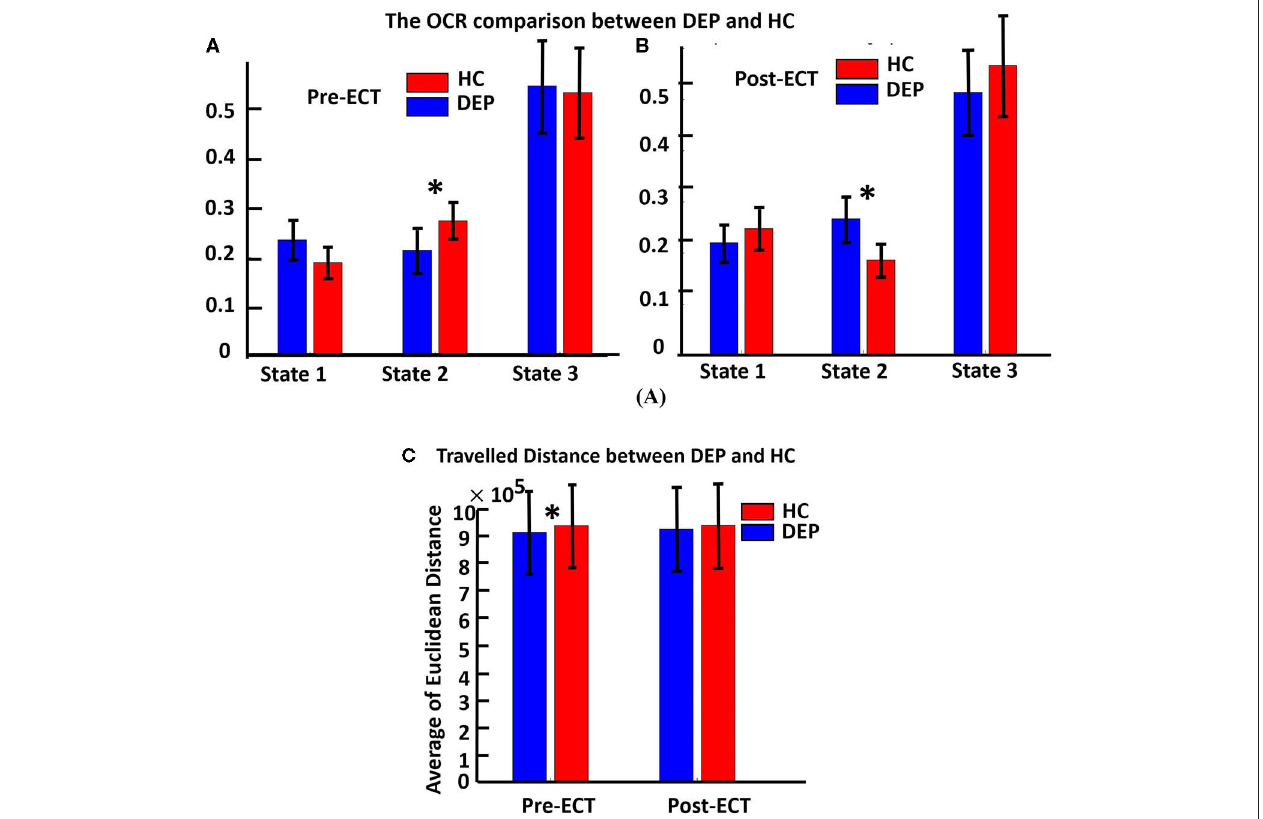
FIGURE 3 | (A) The OCR comparison between DEP and HC in three distinct states of pre-ECT. Red bars indicating the average OCR for a healthy group in each state, and blue bars are for the OCR of the DEP group in each state. OCR features are extracted from dFNC of just pre-ECT (significant difference in state 2, corrected p = 0.015). (B) OCR features extracted from dFNC of just post-ECT (significant difference in state 2, corrected p = 0.03). In state 2, ECT had significantly changed the OCR value of HC and DEP before applying ECT (HC > DEP) compared with after applying ECT (HC < DEP). (C) It shows the traveled distance between the DEP and HC groups in pre-ECT and post-ECT. In pre-ECT, the traveled distance of the HC group is significantly higher than the DEP group ( p = 0.04). After applying ECT, the HC group has higher traveled distance than the DEP group, but this difference is not significant. The significant difference that passes the multiple comparisons is marked by asterisks.